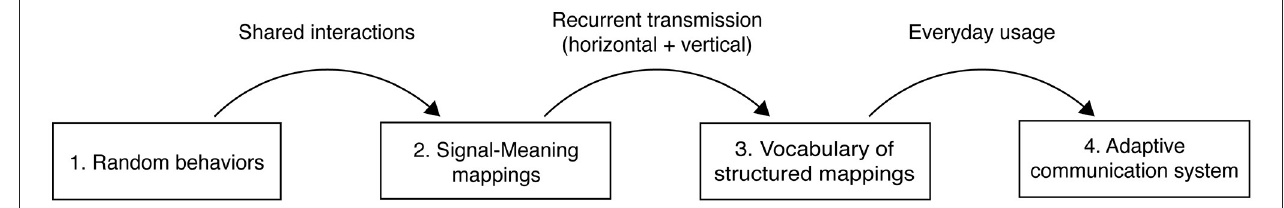
FIGURE 1 | The proposed road of evolving a natural human–machine communication system. First, initially random behaviors obtain meanings and become more structured through recurrent horizontal and vertical transmission. Everyday usage facilitates the continuous evolution of communication systems which are adaptive to biases of humans and